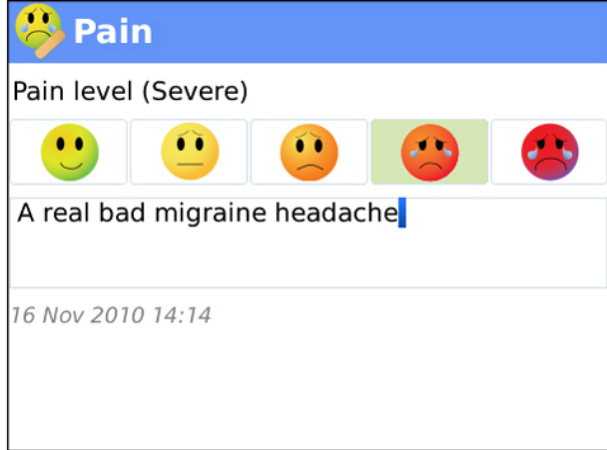
Figure 8. Pain Tracker: Clients can enter subjective pain ratings using a 5-pt scale: pain level is (none, mild, moderate, severe, very severe).